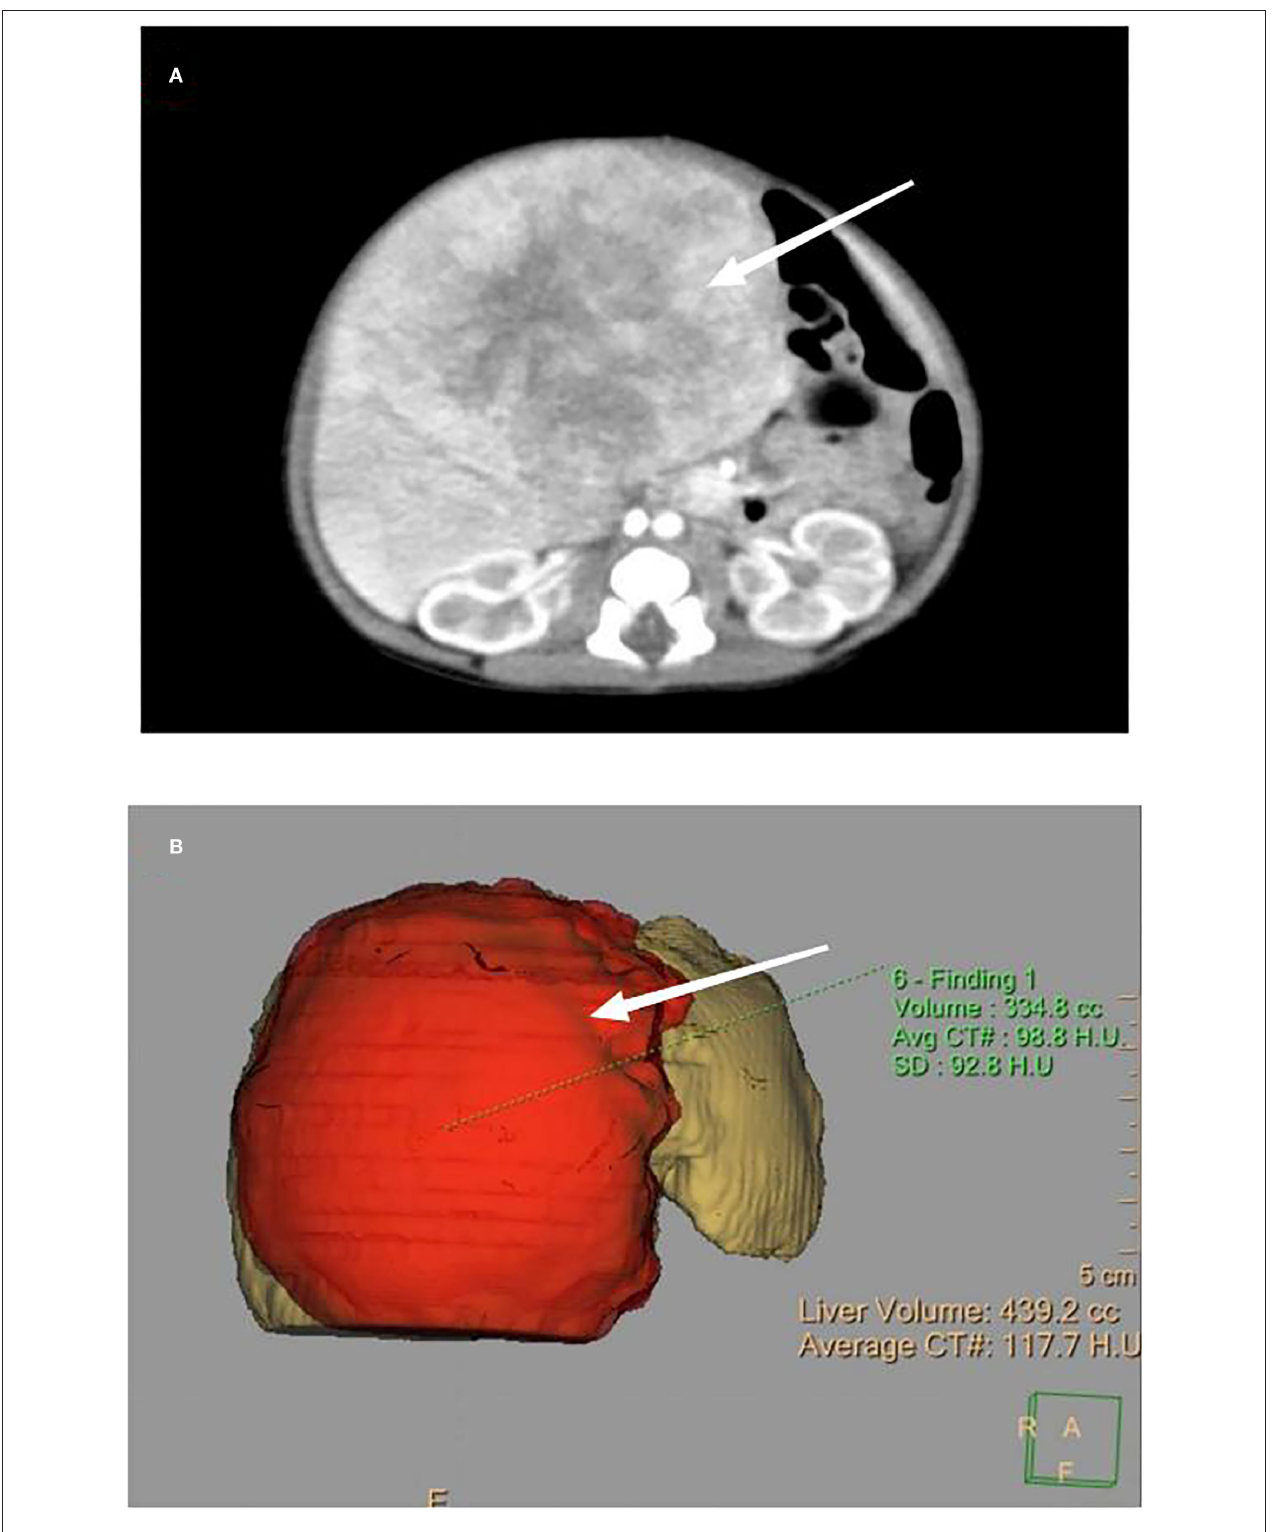
FIGURE 2 | (A) Enhanced CT, as indicated by the arrow, showing a large, round mass with a size of 8.5cm × 6.6cm, a clear boundary, and uneven enhancement. (B) Three-dimensional model of the enhanced CT showing the appearance of the mass.